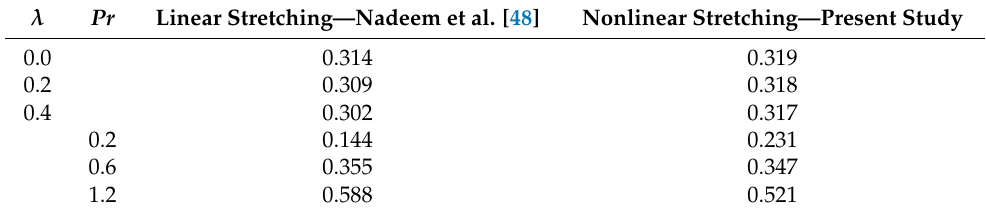
Table 4. Comparison between linear and nonlinear stretching for − θ (cid:48) ( 0 ) by fixing Le = 4, M =